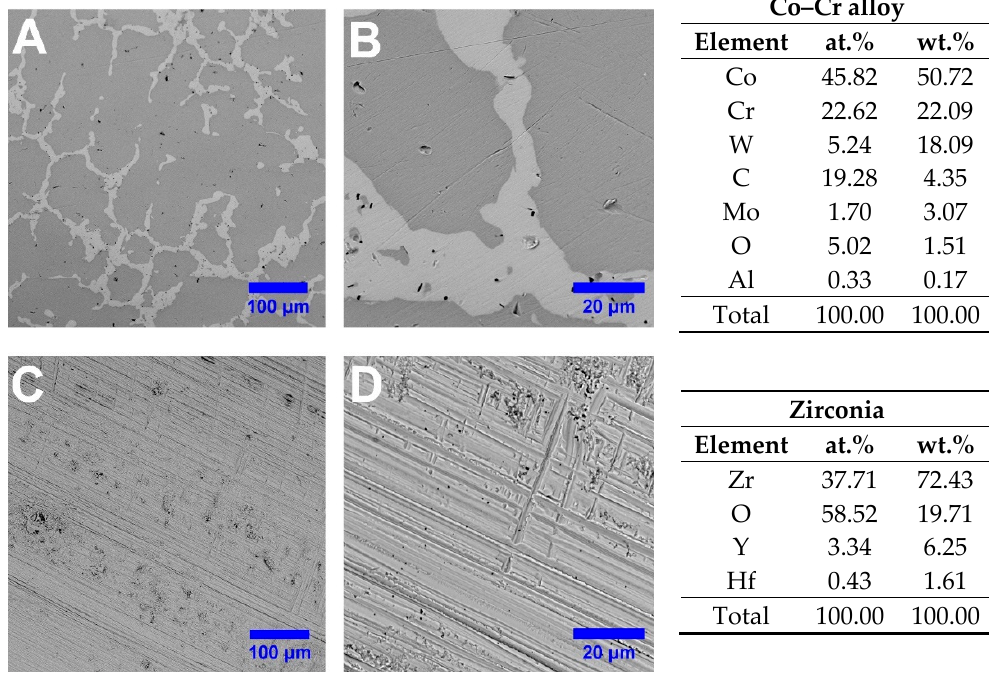
Figure 4. SEM images of a ( A , B ) Co–Cr and ( C , D ) ZrO 2 outer surface of primary telescopic crowns along with the corresponding elemental composition.